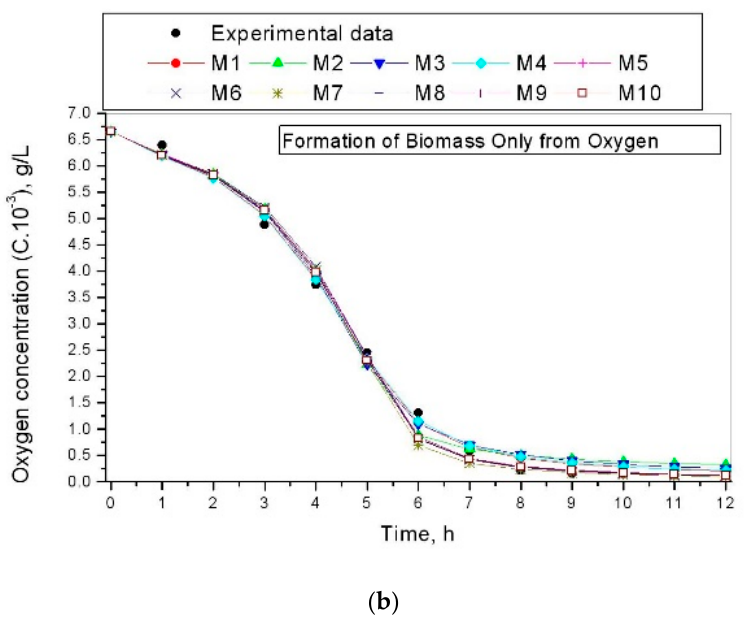
Figure 2. Lactose and oxygen concentration for investigated models: ( a ) lactose concentration for models (1)–(2); ( b ) oxygen concentration for models (3)–(4).